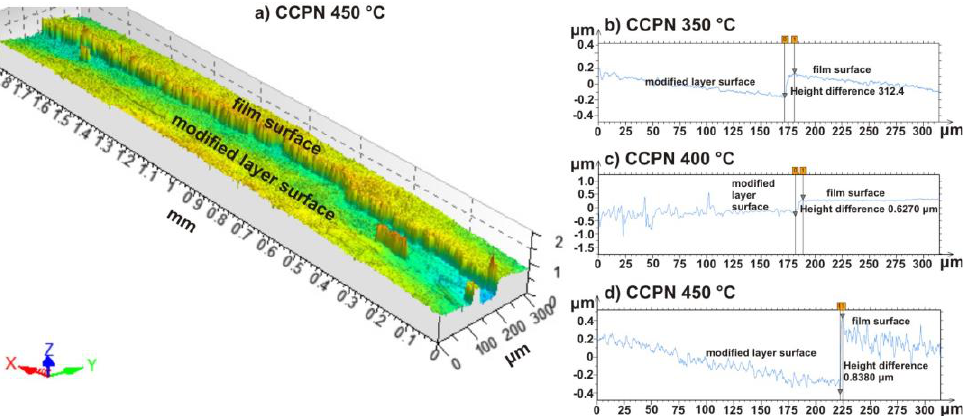
Figure 5. ( a ) Optical interferometry image of a region, on the CCPN 450 °C surface, showing the boundary between the nitride film and the hardened surface below it. ( b – d ) Analyses of the height differences between the film and modified layer surfaces.